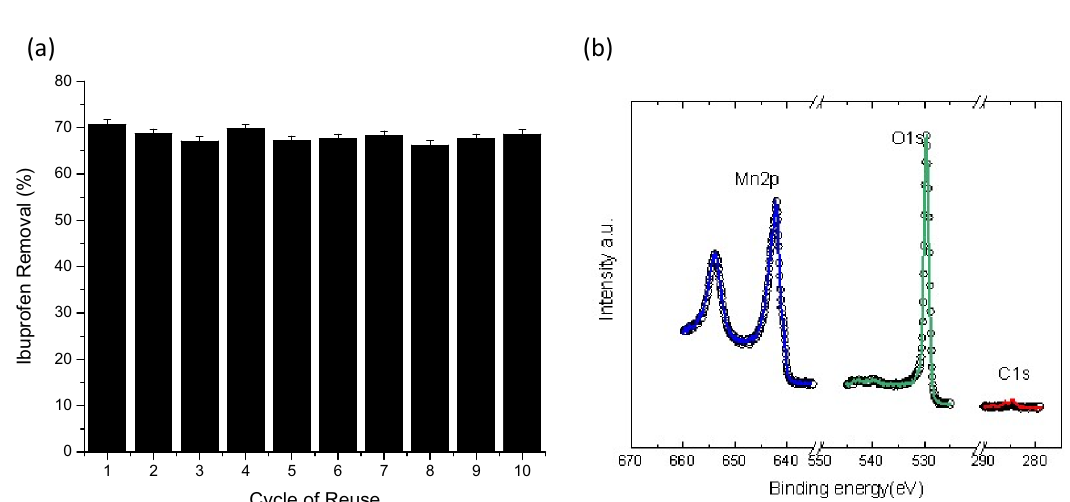
Figure 10. ( a ) Ibuprofen removal efficiency of the catalyst after several cycles of reuse. Experimental conditions: pH—6.5, temperature 20 ± 1 °C, initial Ibuprofen concentration—5 mg/L, catalyst—1.00% (w/v), time—10 min, ozone dose—2 mg/L. ( b ) Catalyst stability by comparing the Mn2p, O1s and C1s core level before (solid line ) and after (dot line) catalytic ozonation. A normalization in intensity was